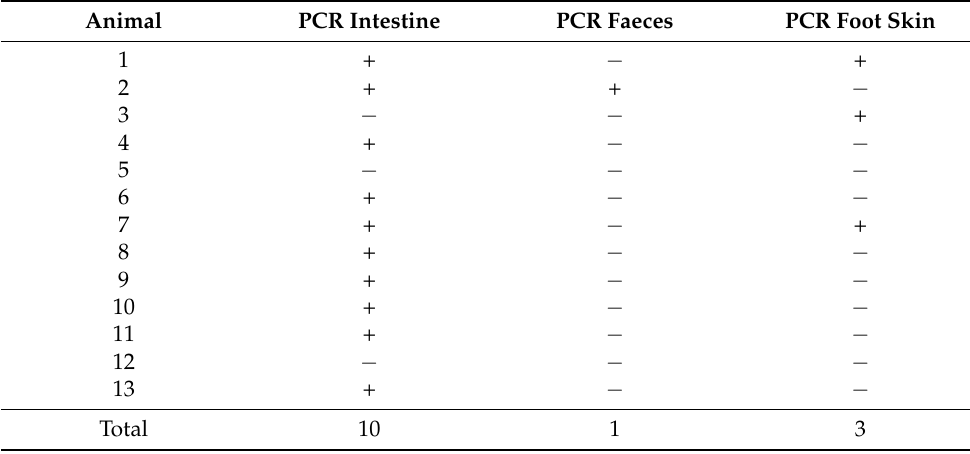
Table 2. Positivity against MAP in PCR samples of intestine, feces, and foot skin of